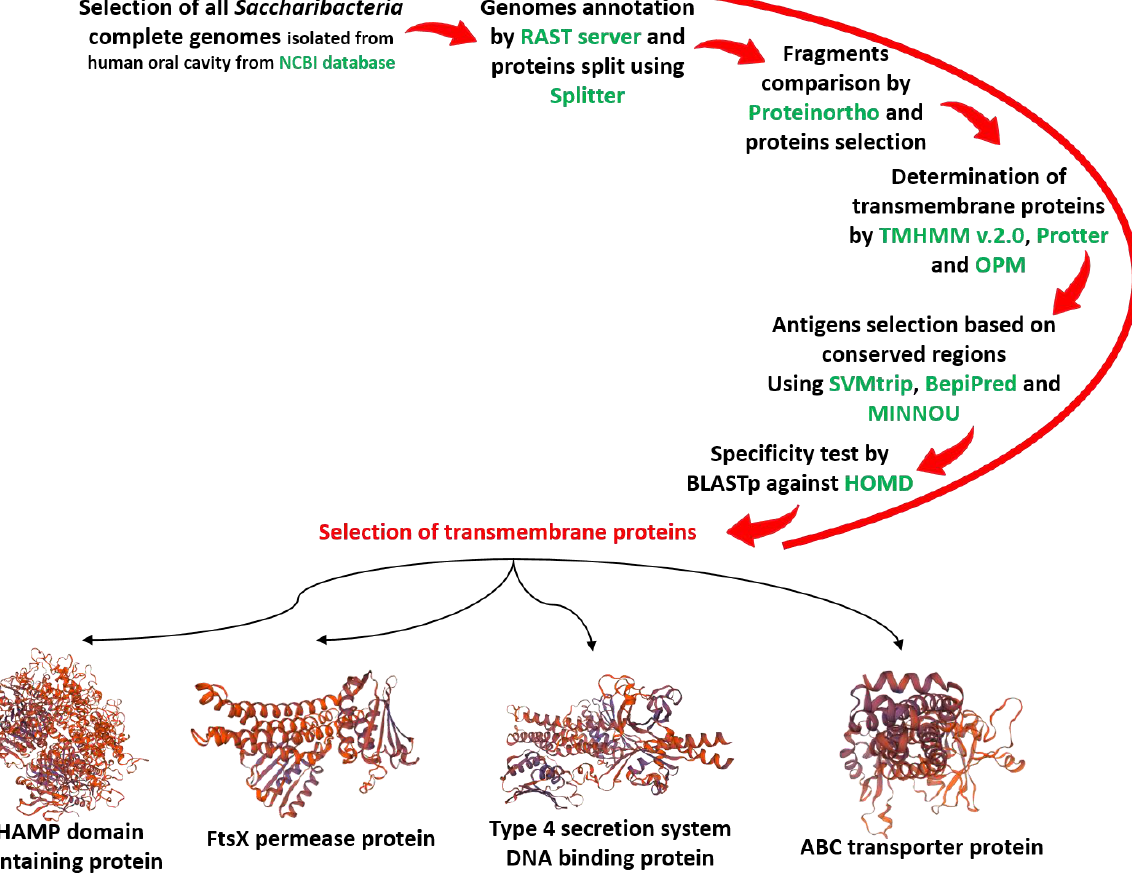
Figure 1. Study design showing the candidature proteins found. All bioinformatics pipelines used in this study are marked in green.